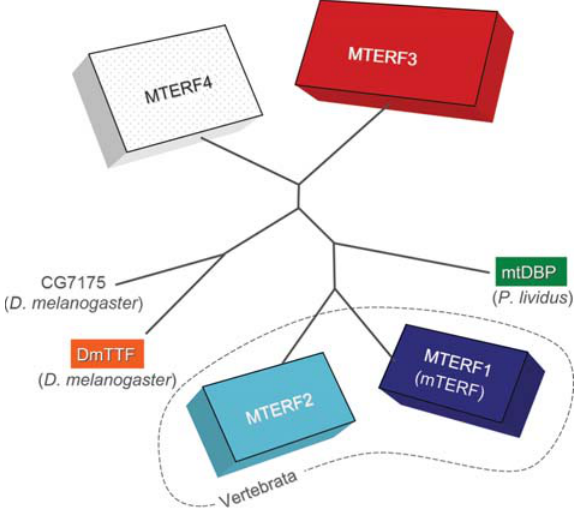
Figure 3 Schematic diagram illustrating the main phylogenetic relations in MTERF protein